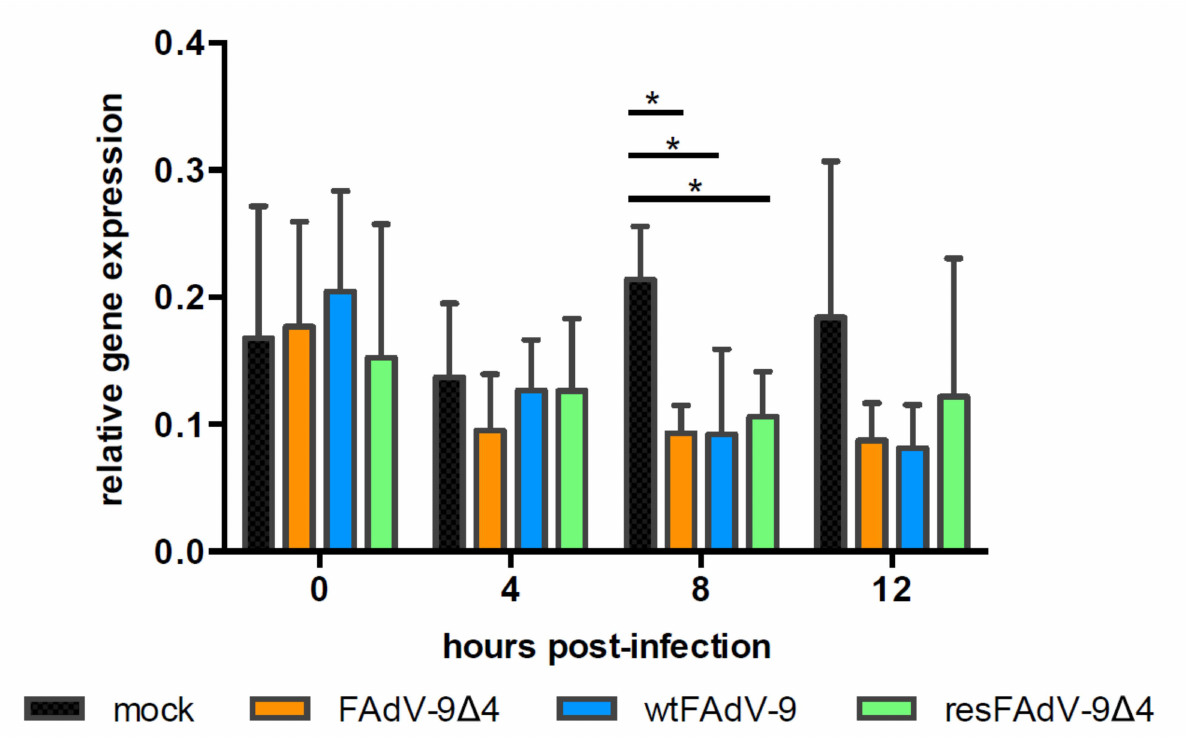
Figure 3. Quantitative RT-PCR of MHC-I (BF2) mRNA. CH-SAH cells were mock infected or infected with FAdV-9, FAdV- 9 ∆ 4, and resFAdV-9 ∆ 4 at an MOI of 5. Total RNA was prepared from these cells at the times indicated post-infection and was subjected to quantitative real-time PCR with primers to MHC-I and β -actin. MHC-I mRNA levels were normalized to β -actin levels, and the resulting relative quantification is shown. Means ± SD from two independent experiments are shown. An asterisk (*) indicates a significant difference ( p < 0.05) by Student’s T test in comparison to the other 3 groups at that time